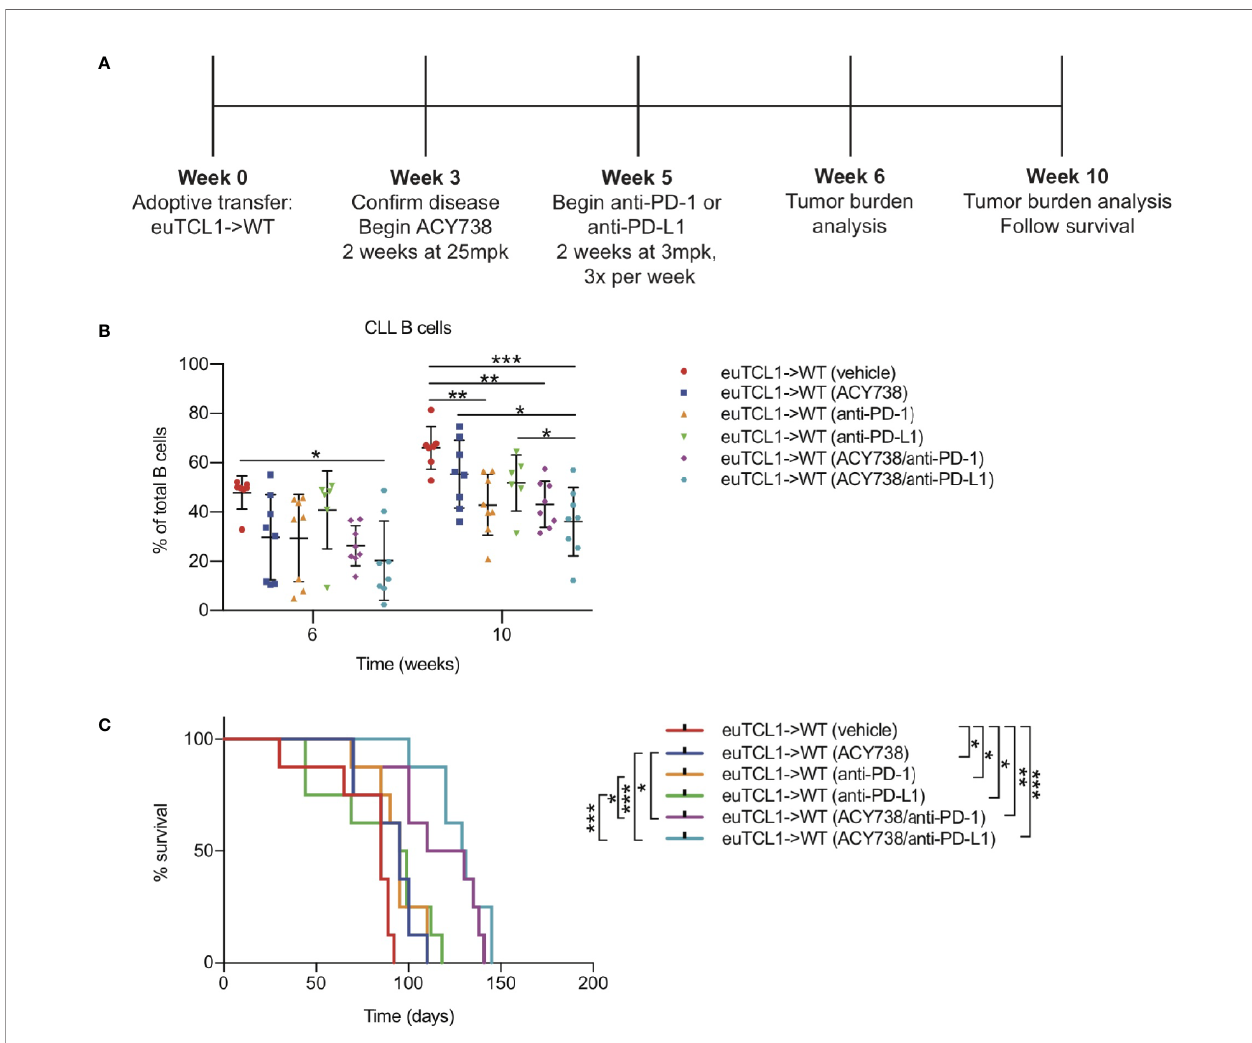
FIGURE 5 | Combinatorial antitumor ef fi cacy of ACY738 and PD-1/PD-L1 blockade in CLL. (A) Timeline showing experimental protocol. (B) Flow cytometry to detect tumor burden in fresh PBMCs. CLL B cells were gated as CD3 - CD19 + B220 lo IgM hi CD5 + cells. Total B cells were gated as CD3 - CD19 + B220 + cells. (C) Kaplan-Meier curve showing survival analyses for mice in panel (A) . n = 8 mice per group. Representative of three independent experiments. Graphs display mean + SD. * p < 0.05, ** p < 0.005, *** p <